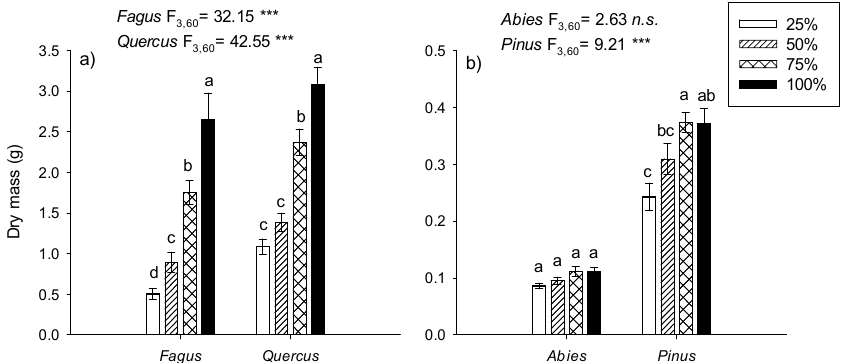
Figure 2. Total plant dry mass of ( a ) Fagus sylvatica and Quercus petraea , and ( b ) Abies alba and Pinus sylvestris seedlings grown at di ff erent irrigation treatments (100%, 75%, 50%, and 25% of the recommended dose). Bars indicate means ± SE ( n = 16). Note the di ff erent scales. One-way analysis of variance F -values for treatment e ff ect and the associated p values are shown separately for each species (*** p < 0.001, n.s.—not significant). Means marked by the same letters (a, b, c) within species were not significantly di ff erent.